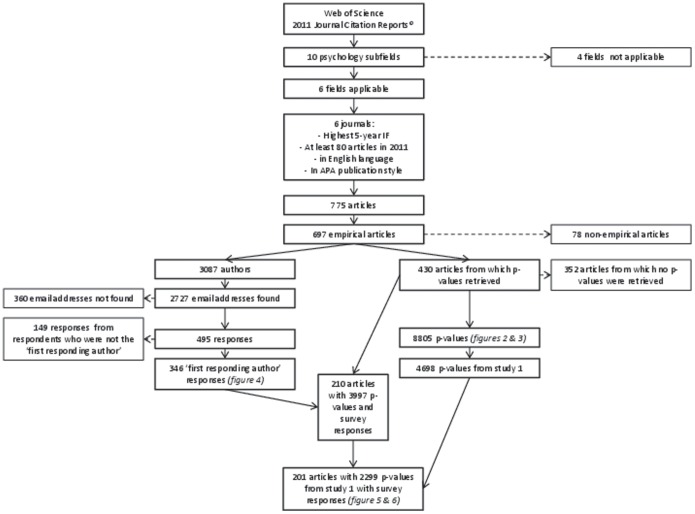
Flow chart for composition of sample.